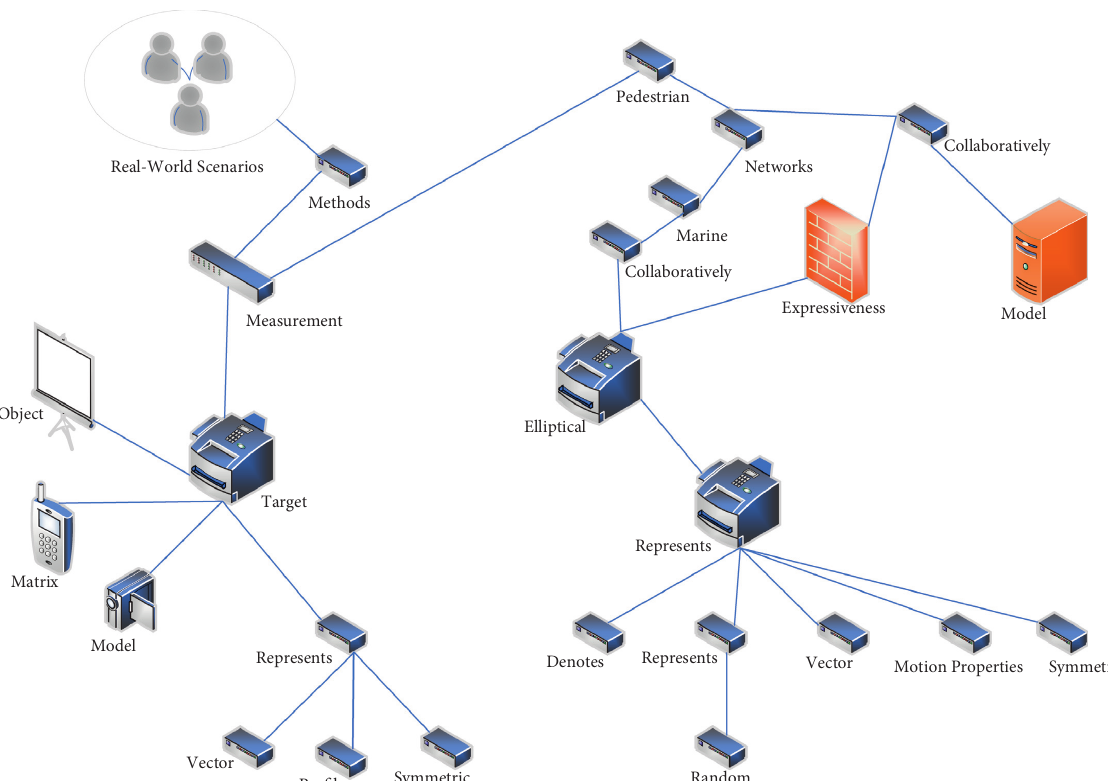
Figure 2: Schematic diagram of Bayesian algorithm.